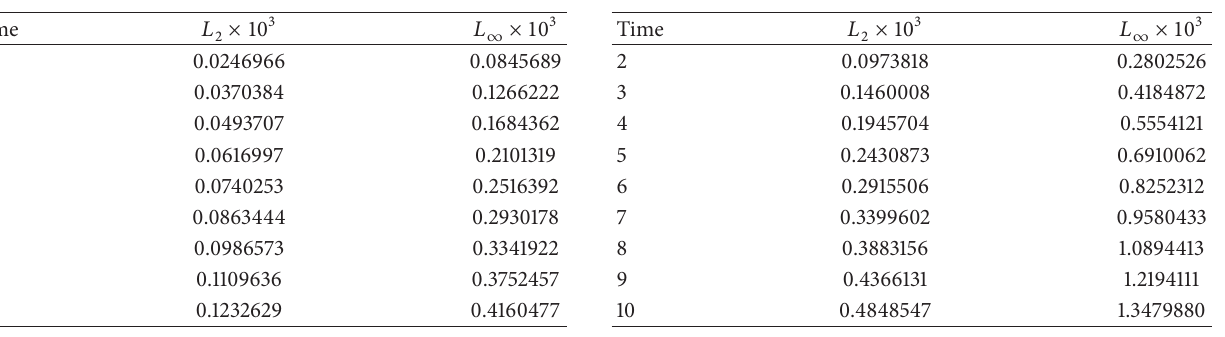
Table 4: 𝐿 2 and 𝐿 ∞ error norms for ℎ = 0.02 , Δ𝑡 = 0.01 , and V = 0.01